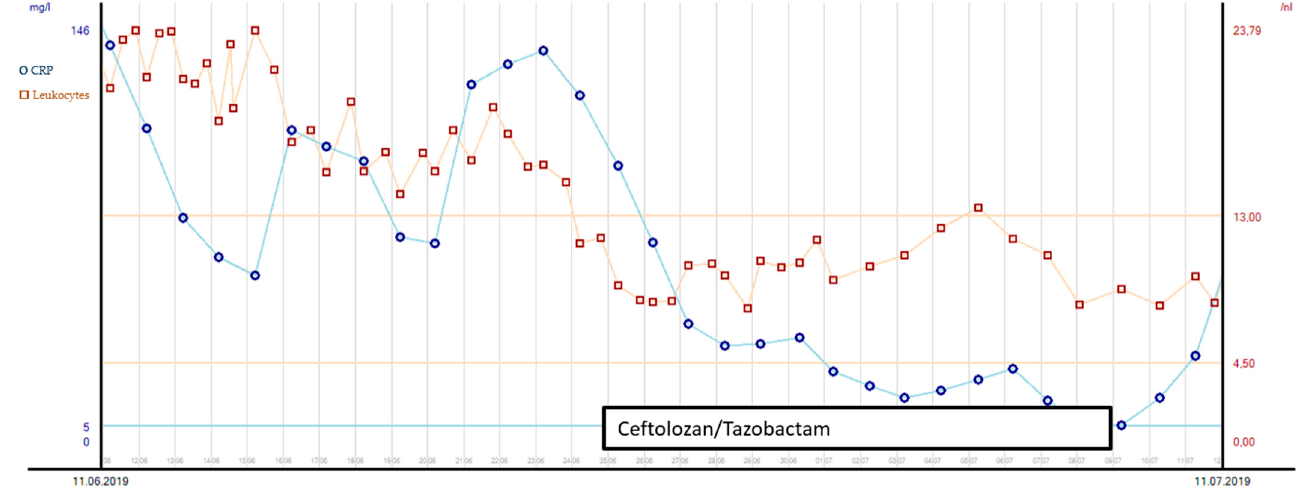
Figure 2. Leucocyte count, PCT and CRP course with corresponding antibiotic treatment during the first 30 days after ICU admission.